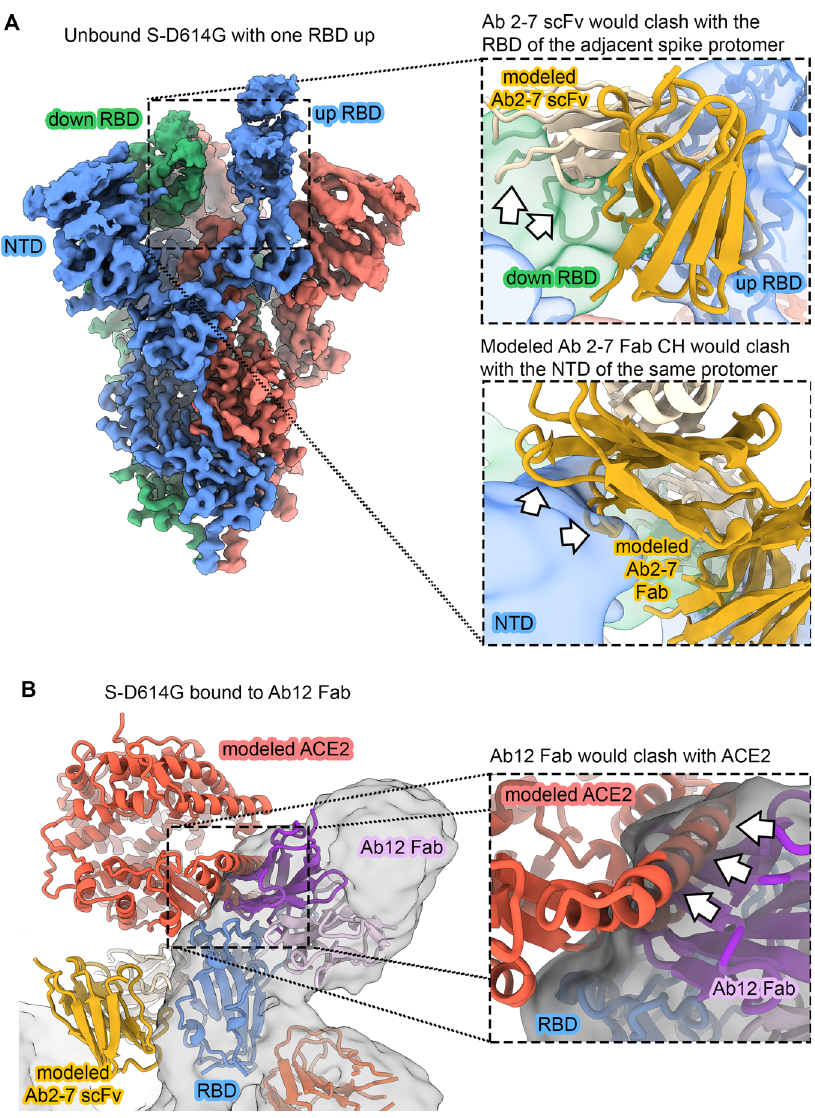
Fig.3|Ab2-7canonlybindasanscFvandAb12competeswithACE2.A Cryo-EM reconstruction of unbound S-D614G with one RBD in the up conformation (3.0Å). Coloring isthe same asin Fig. 2. The inset at the top right shows thatAb2-7 would clash with the “ down ” RBD of the neighboring spike protomer (green cryo-EM reconstruction, fi ltered to 6Å). The inset below shows Ab 2-7 modeled as a Fab,